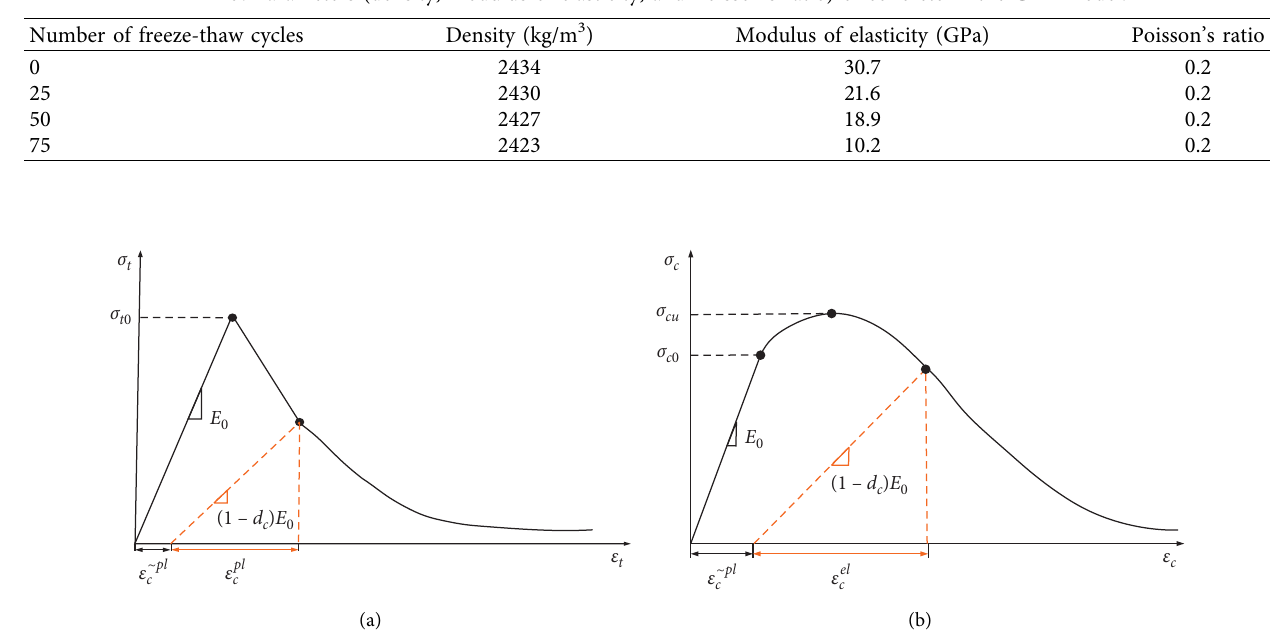
Figure 4: Response of concrete to uniaxial loading in tension and compression: (a) tension data; (b) compressive data [22].